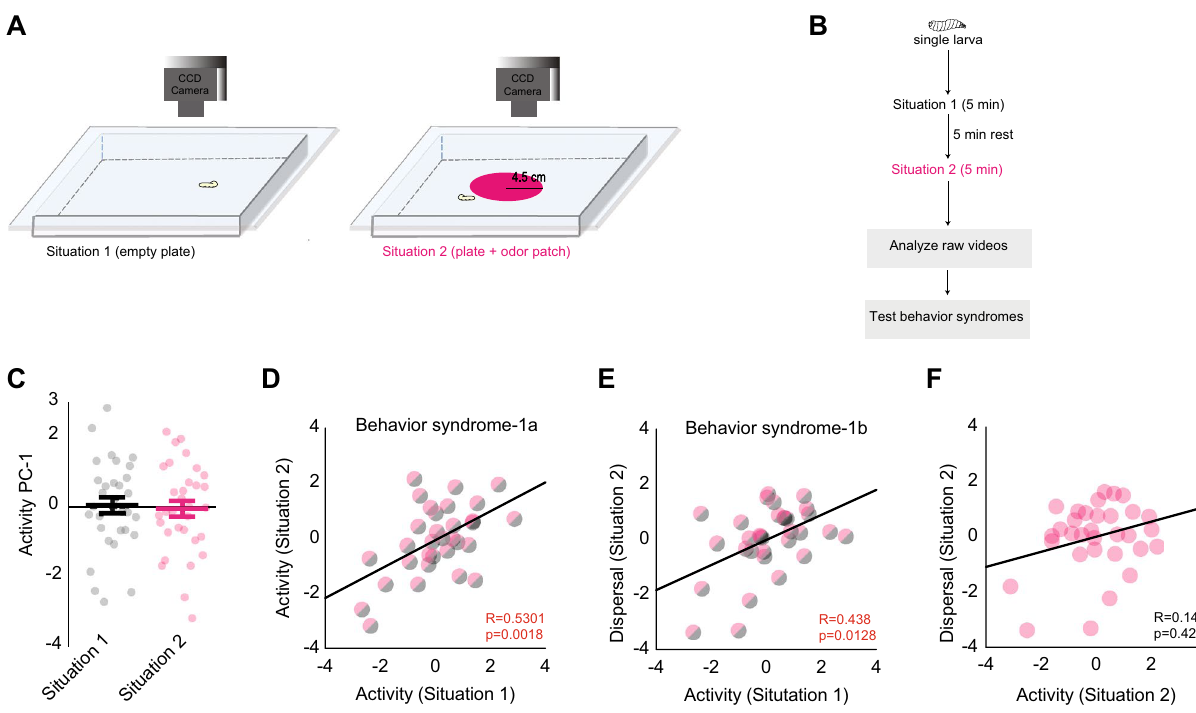
Figure 1. Experiment 1: Stability of olfactory behavior syndromes. ( A ) A single wild-type larva is exposed to situation 1 (left, empty plate); situation 2 (right, plate with odor patch). Larval movements are recorded by a CCD camera, n = 32. Adapted from Mathew et al.25. ( B ) A schematic of the paradigm is provided on the right. ( C ) Average activity measure for larvae in situation 1, n = 32, and situation 2, n = 32. Repeated measures t-test, p = 0.659. ( D ) Correlation between the activity of a larva in situation 1 and its activity in situation 2. p < 0.05, Pearson’s correlation, n = 31. ( E ) Correlation between the activity of larva in situation 1 and its